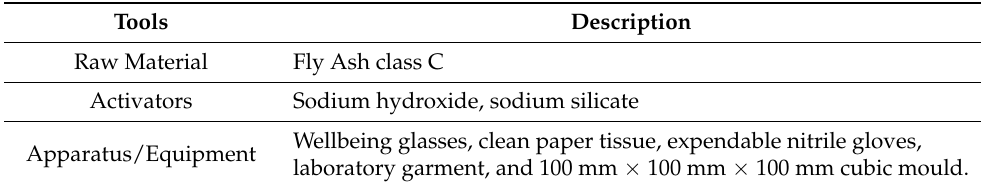
Table 1. List of required tools in making geopolymer.